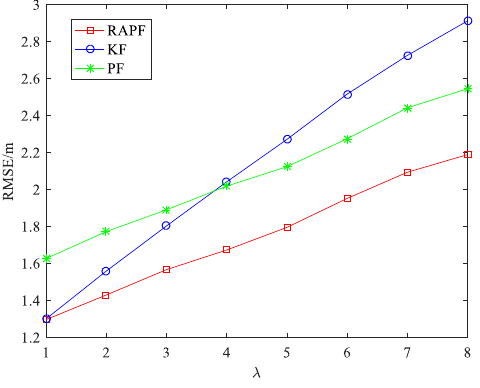
Figure 18. The RMSE versus the parameter λ